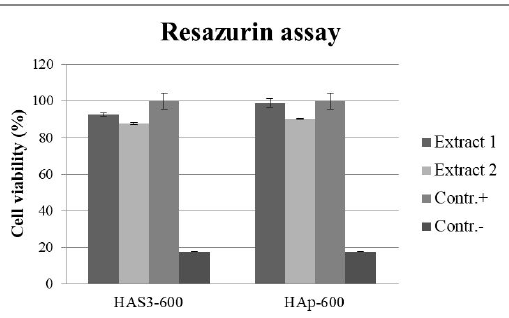
Figure 9. Cell viability for dental pulp cells in contact with the extracts obtained for 24h (extract 1) and 48h (extract 2) for a 24h incubation period. Cell culture with supplemented culture medium was used as positive control (contr.+) and as negative control was used standard supplemented culture medium with 50% (v/v)